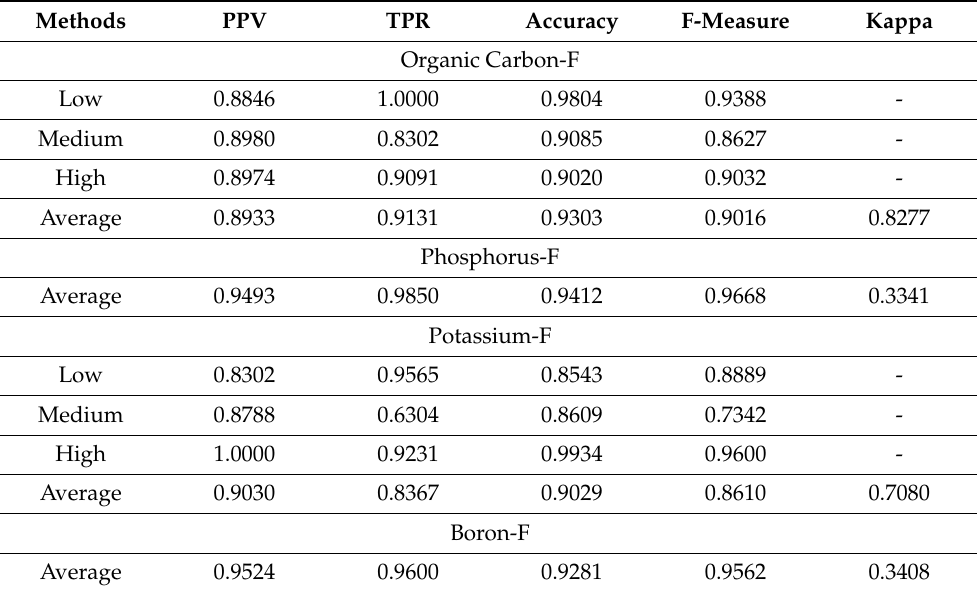
Table 1. Result analysis of ISNpHC-WVE technique on soil nutrient